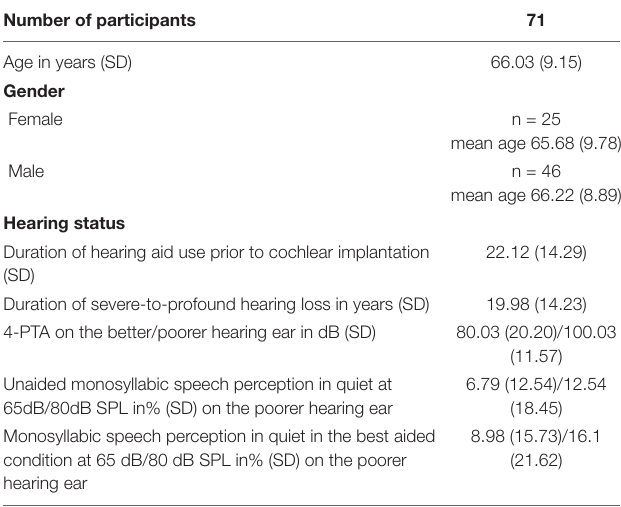
TABLE 1 | Demographic and audiometric data prior to implantation standard deviation (SD); 4-pure-tone average (PTA); sound pressure level